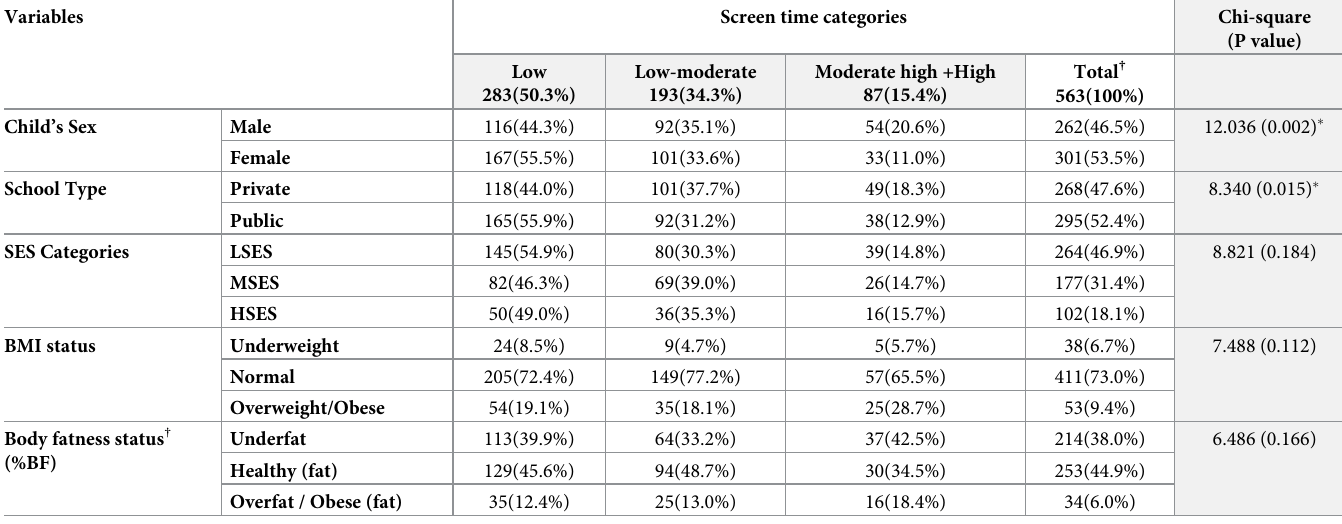
Table 4. Association of overall ST levels and participant’s sex, school type, SES, BMI and %BF status.